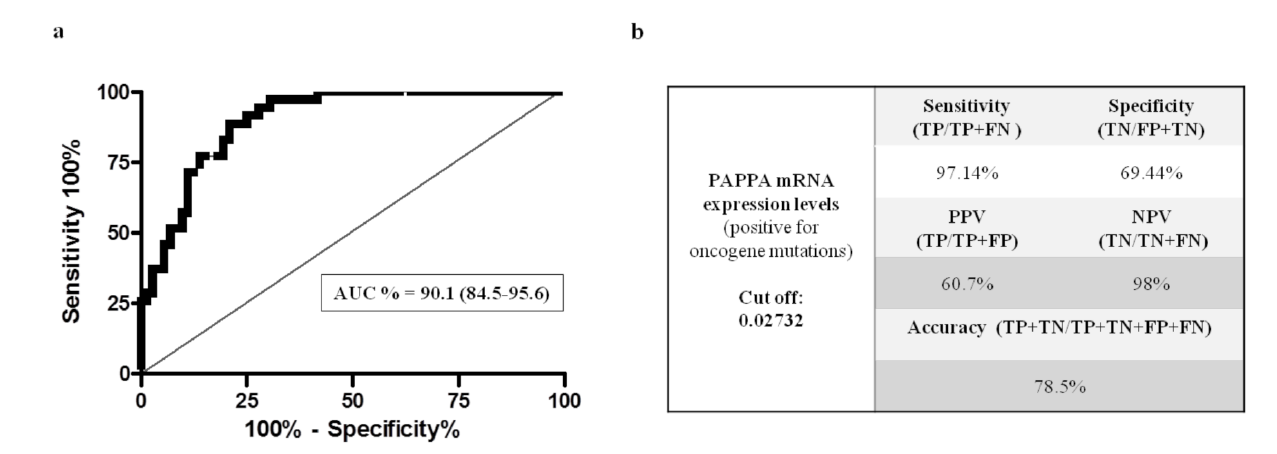
Figure 2. Diagnostic performance of the PAPPA mRNA expression levels in 107 cytological samples. ( a ) Receiver operating characteristic (ROC) curve and related area under the curve (AUC) of PAPPA expression to discriminate cytological samples positive for seven-gene panel. ( b ) The sensitivity, specificity, negative predictive value (NPV) and positive predictive value (PPV) of PAPPA expression with the cut off set at 0.02732. Abbreviations: TP, True positive; TN, true negative; FN, false negative; and FP, false